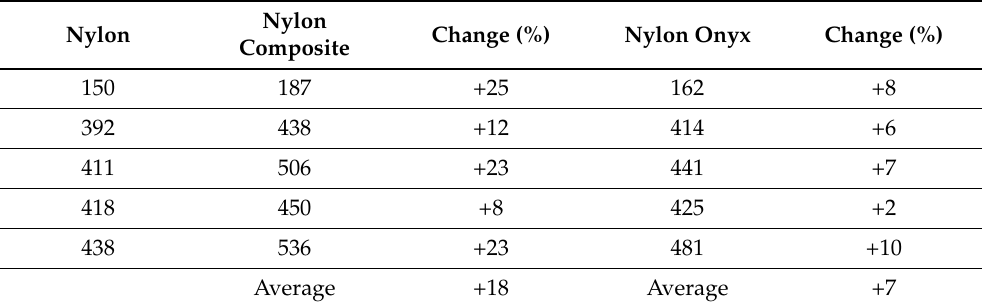
Table 5. First five natural frequencies of honeycomb lattice structure in the bottom-clamped boundary condition and the paired modes when the material of vertical parts of honeycomb lattice structure changed to composite or onyx.